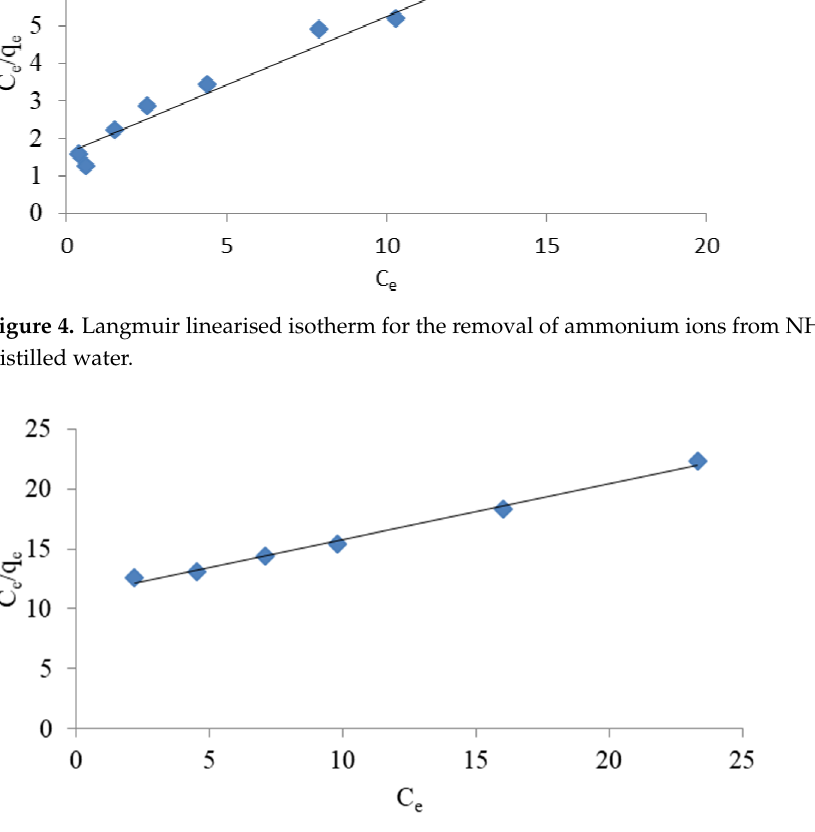
Figure 5. Langmuir linearised isotherm for the removal of ammonium ions from NH 4 Cl solution in tap water.